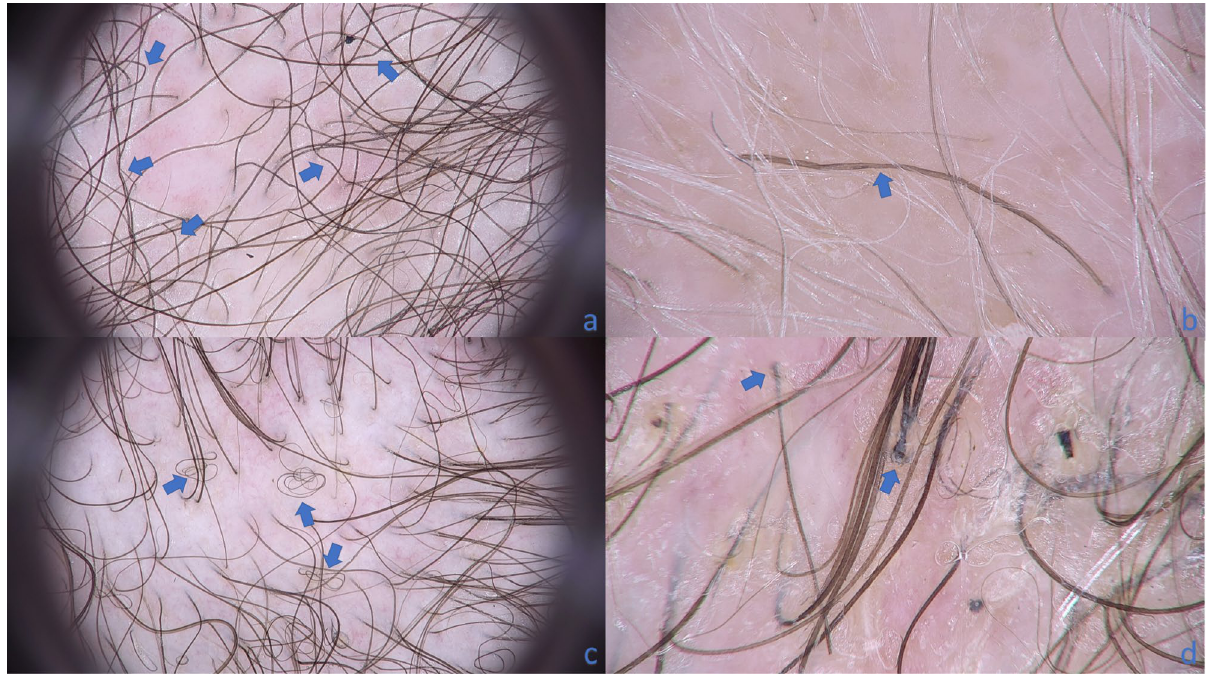
Figure 1. Hair shafts abnormalities seen in patient with erythrodermic CTCL. (a) Numerous pili torti seen in trichoscopy as bent hair shafts (blue arrow) (× 20). (b) Trichoscopy without immersion fluid and in high magnification shows short hair shaft with torsions along own axis (marked with blue arrow) (× 70). (c) Trichoscopy of erythrodermic CTCL with numerous hair shafts described as 8-shaped hairs (blue arrows) (× 20). (d) Visible anagen bulbs (blue arrow) (×